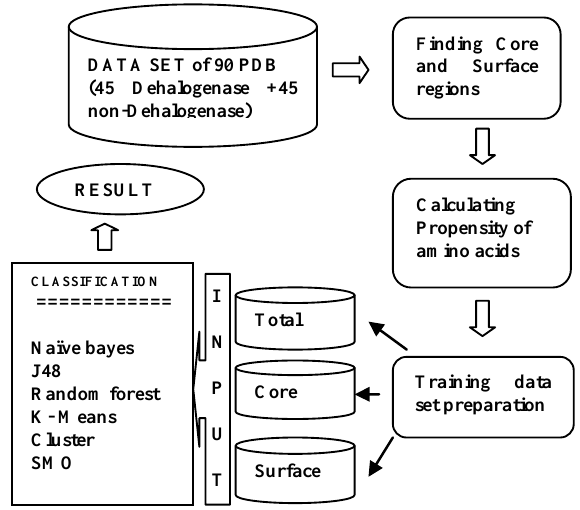
Figure 1. Schematically representation of steps followed in this work.